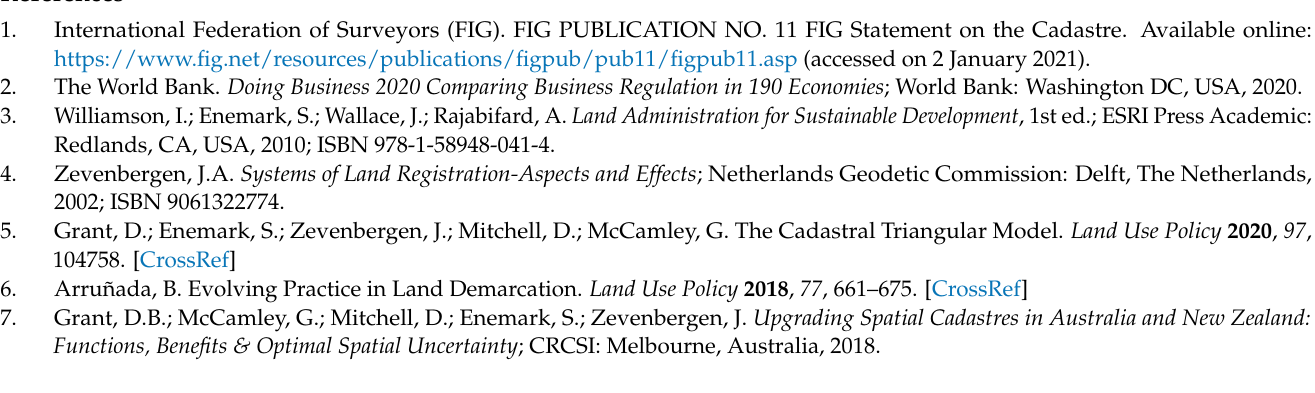
Figure A2. The compliance of spatial element in Lagoa Ward (map background: Open- streetmap).